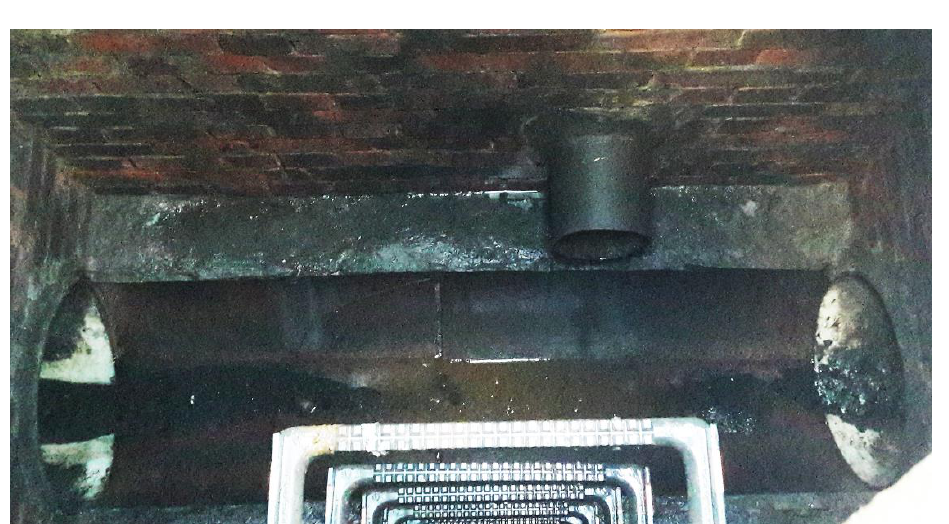
Figure 18. ( a ) The linear element identified in the echogram but not present on the map, ( b ) the C- scan view at the location of the heating and power network.